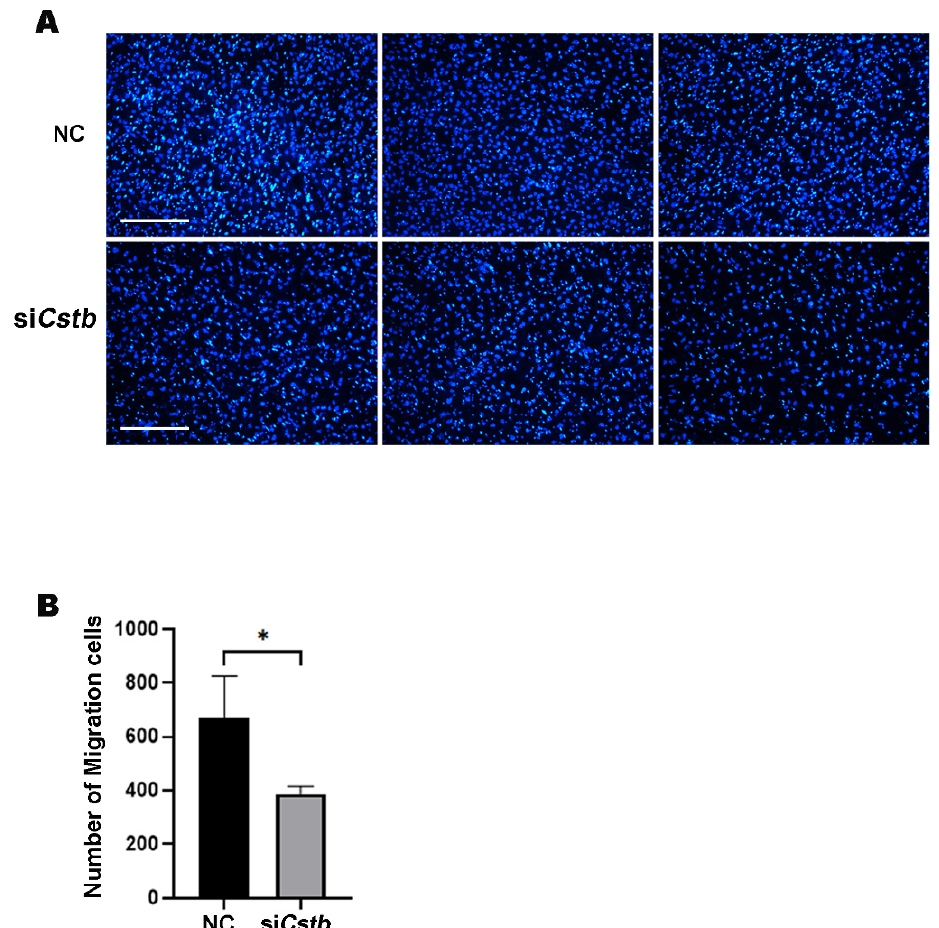
Figure 5. Cstb promotes the migration of mouse uterine stromal cells. ( A ) Stromal cells were treated with ordinary medium and transfected with siRNA for 12 h. Cells migrating to the lower layer of the transwell were stained with DAPI (blue) by immunofluorescence. Bar = 300 μ m. ( B ) The number of stromal cells was examined. NC, negative control; si Cstb , siRNA of Cstb . * p < 0.05.